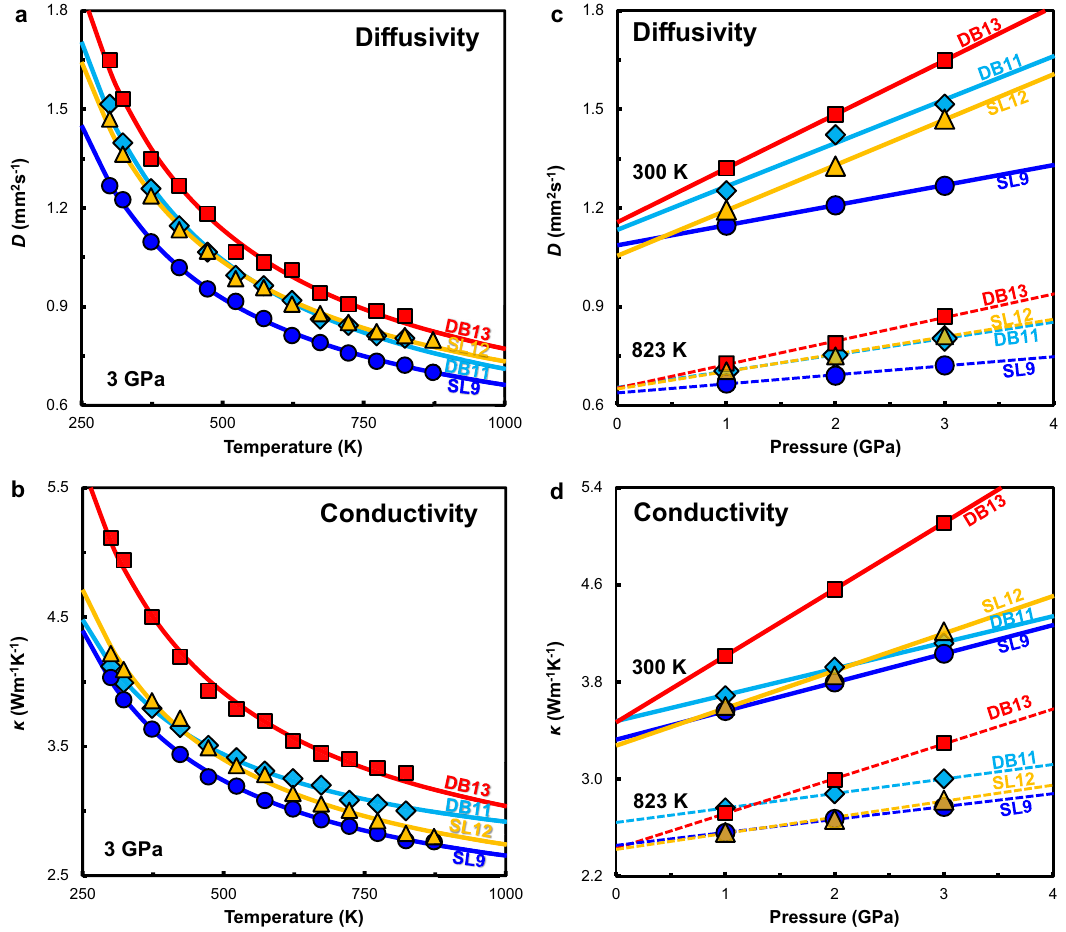
Fig. 1 | Temperature and pressure dependences of the thermal diffusivity ( D ) and conductivity ( κ ) of eclogite. a Temperature dependence of D at 3GPa. b Temperature dependence of κ at 3GPa. c Pressure dependence of D at 300 and